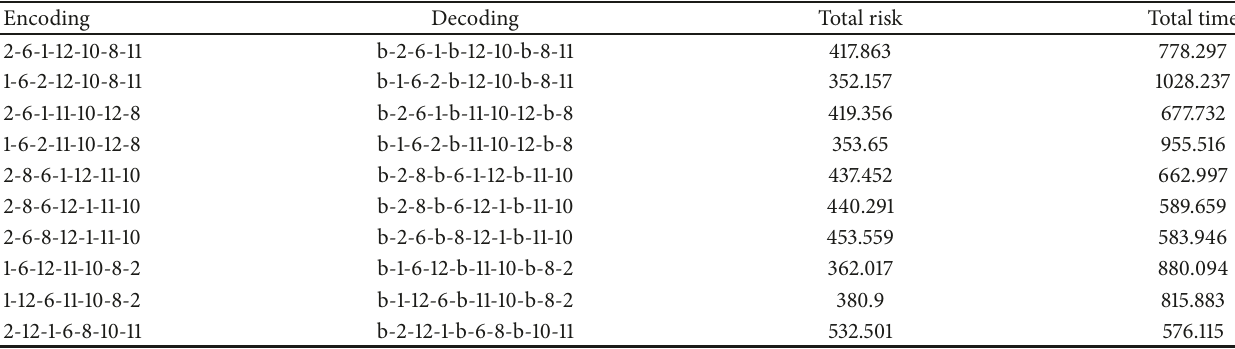
Table 10: Pareto solution set of robust control parameters Γ =20 for distribution center